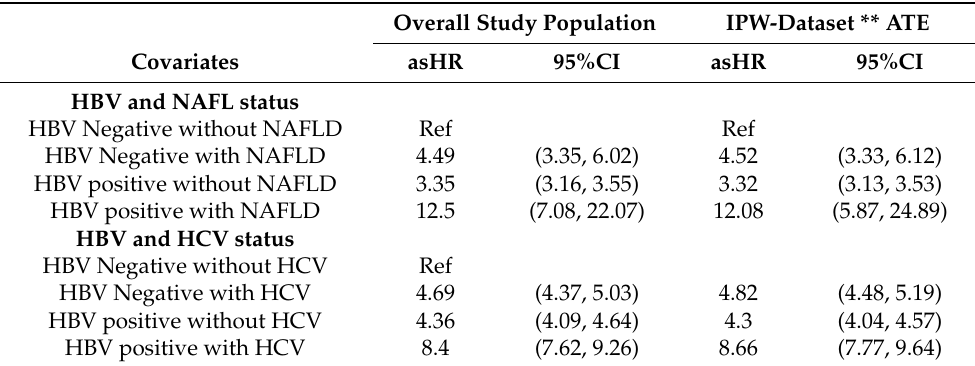
Table 3. Impact of HBV infection, NAFLD, and HCV on liver-related mortality between 1990–2015 in the British Columbia Hepatitis Testers Cohort, using the multivariable* Fine–Gray sub-distribution proportional hazards model